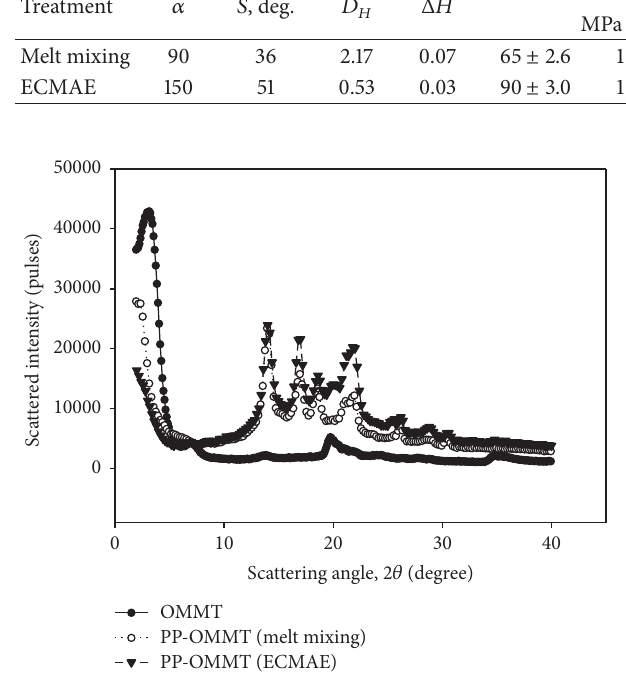
Table 1: Structural, physical, and mechanical characteristics of the PP- \ MMT nanocomposite. Treatment